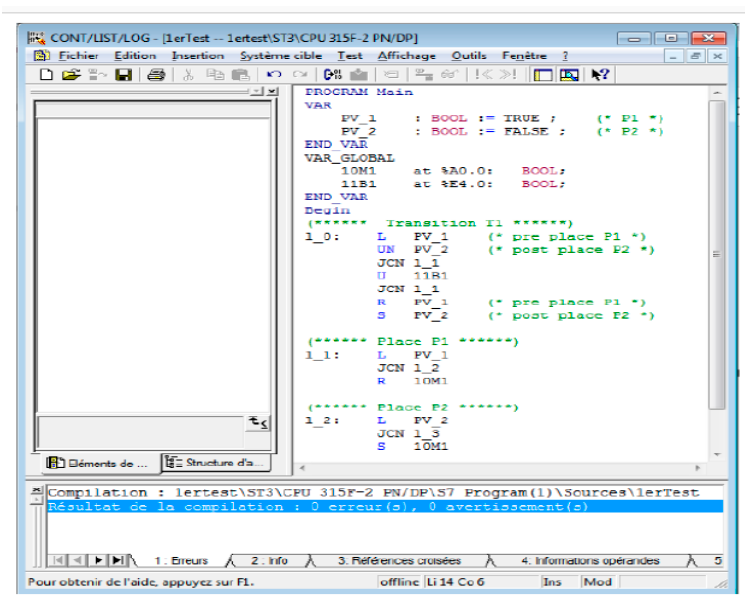
Figure 8. The testing code using STEP 7.